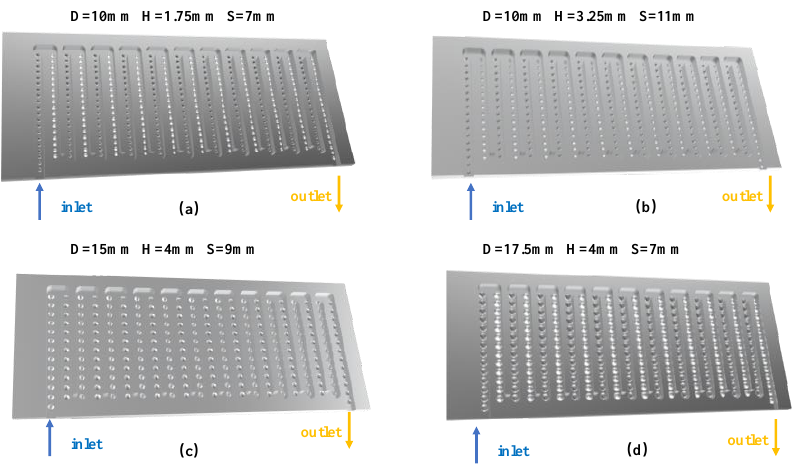
Figure 7. ( a ) Flow channel design drawings for groups I ( b ) Flow channel design drawings for group III ( c ) Flow channel design drawings for group XII ( d ) Flow channel design drawings for group XVI.